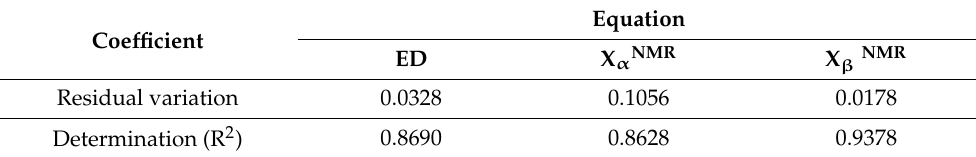
Table 5. The statistical analysis of the presented mathematical